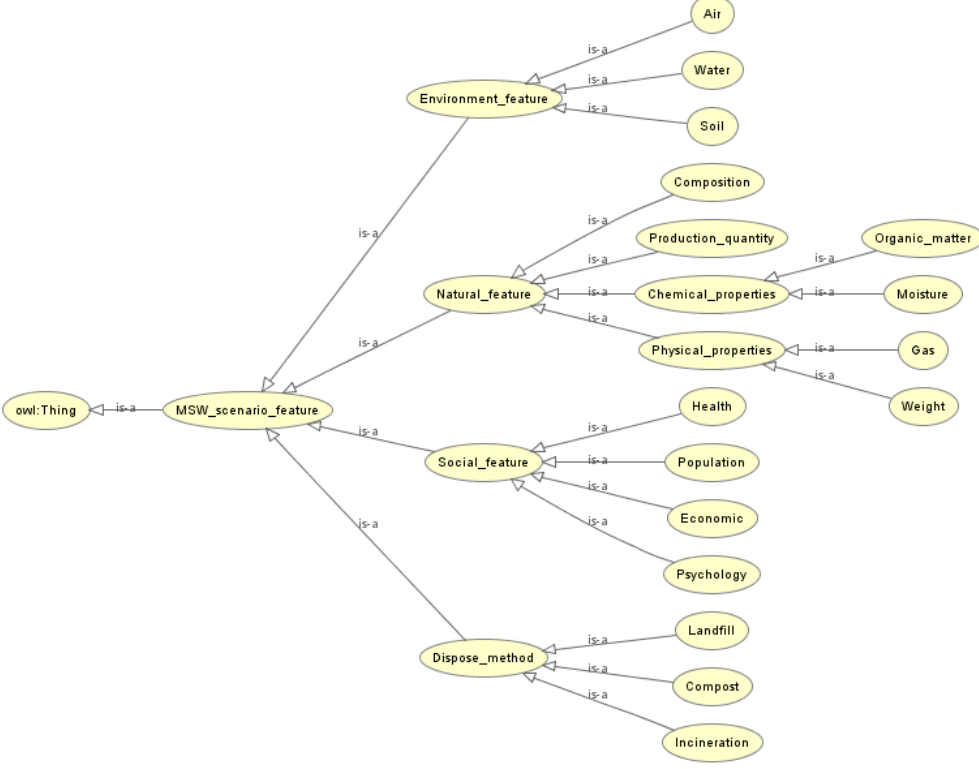
Figure 4. MSW scenario feature ontology model.